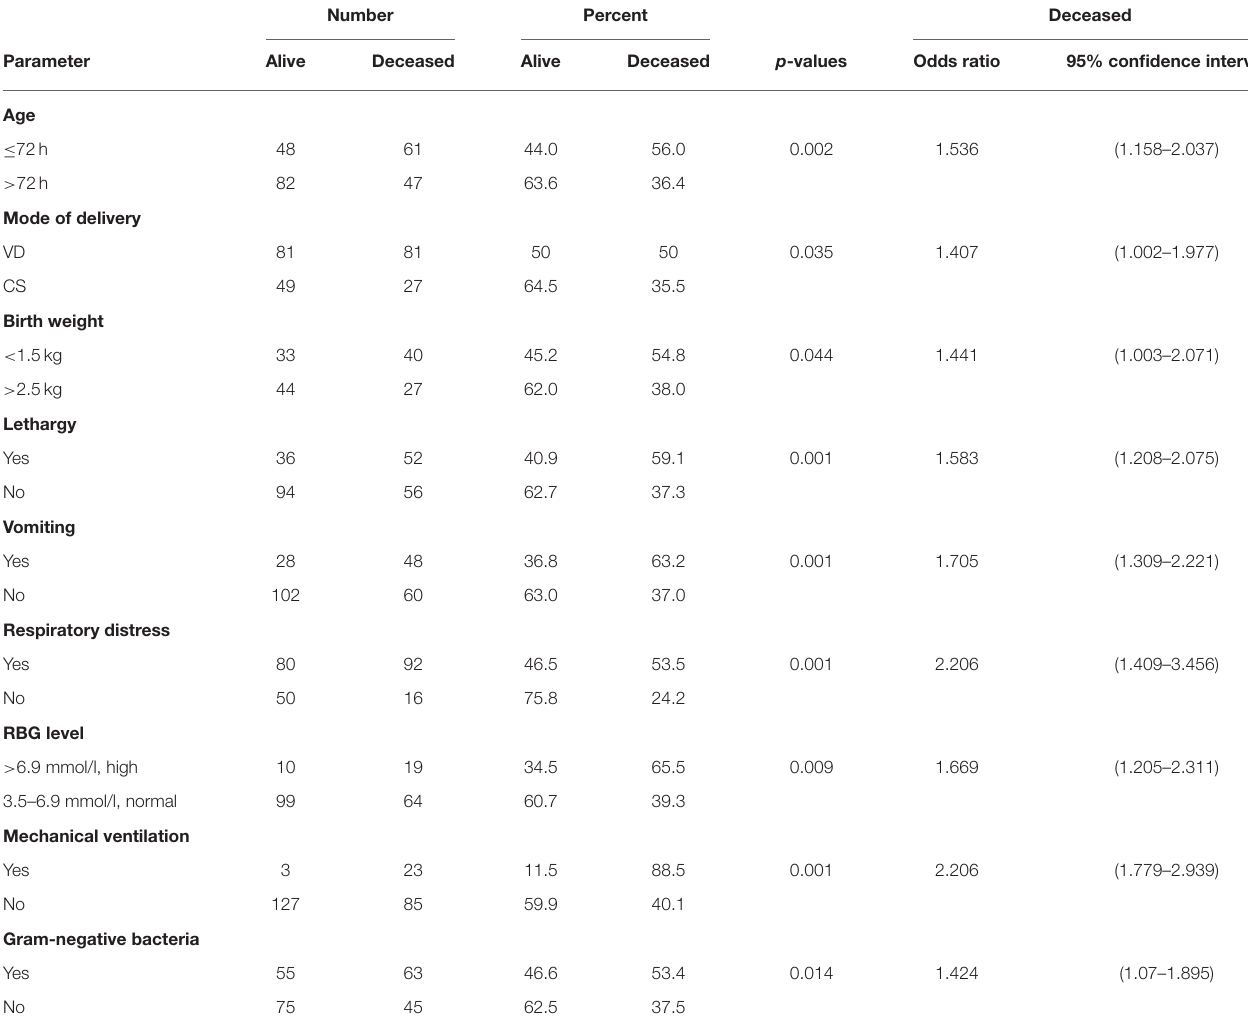
TABLE 3 | Risk estimate analysis of the association factors to death among septicemic babies. Number Percent